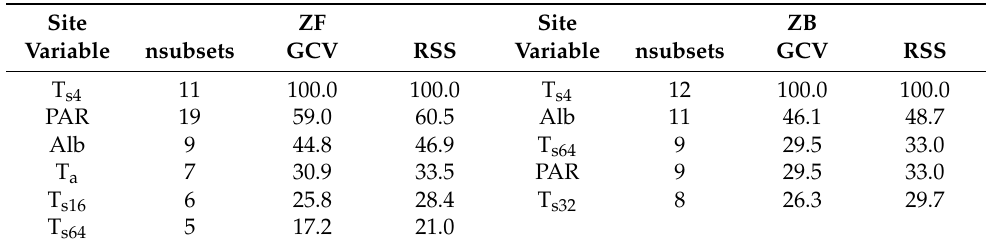
Table 3. The order of important variables with statistics (nsubsets, GCV, and RSS; see details